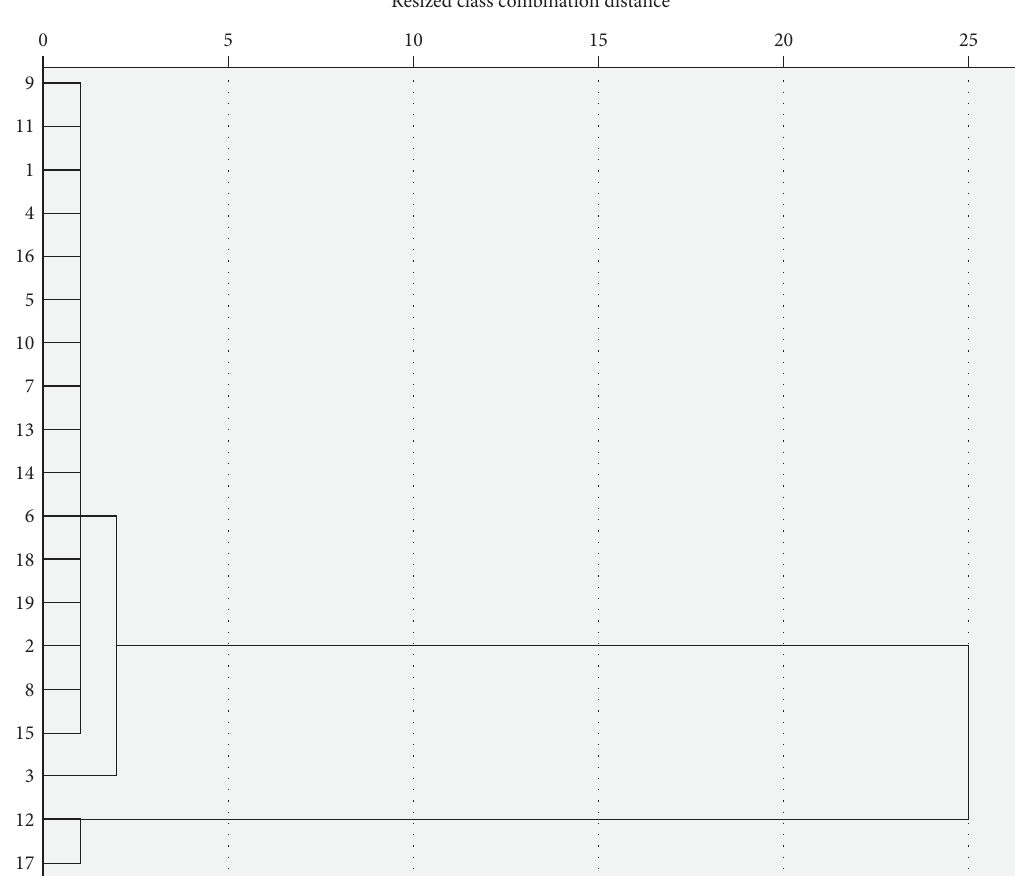
Figure 7: Dendrogram of nineteen Angads groundwater sample